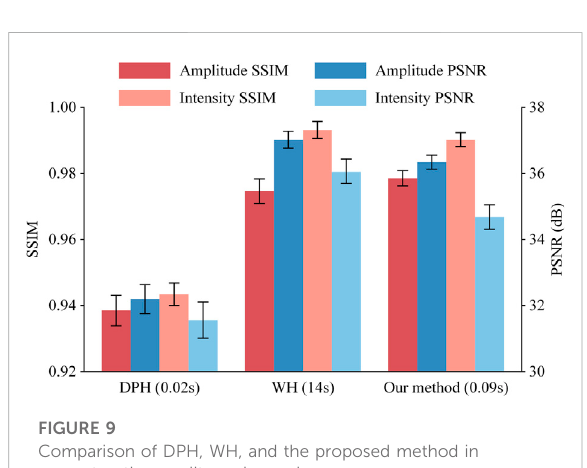
FIGURE 8 Probability of perturbations in different standard deviation ranges. The horizontal axis is the standard deviation of therandom perturbation and the vertical axis is the corresponding